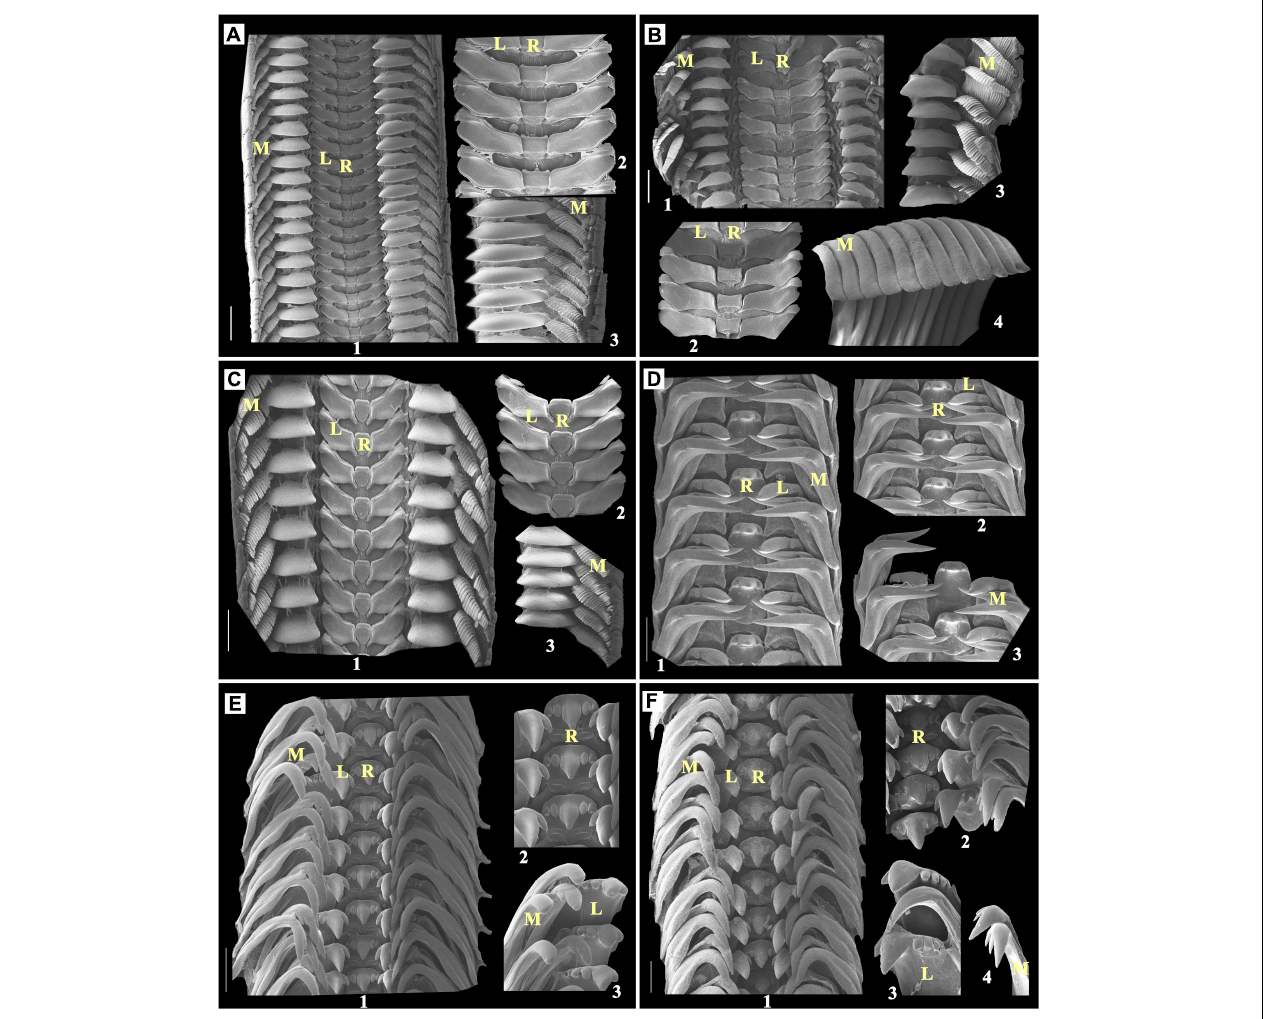
FIGURE 3 | (A) Nerita albicilla , Scale bar: 300 µ m; (B) Nerita costata , Scale bar: 300 µ m; (C) Nerita undata , Scale bar: 200 µ m; (D) Naria sp., Scale bar: 200 µ m; (E) Cerithium coralium , Scale bar: 100 µ m; (F) Rhinoclavis sinensis , Scale bar: 100 µ m; 1: radula; 2 and 3: enlarged part of radula; R, rachidian teeth; L, lateral teeth; M, marginal